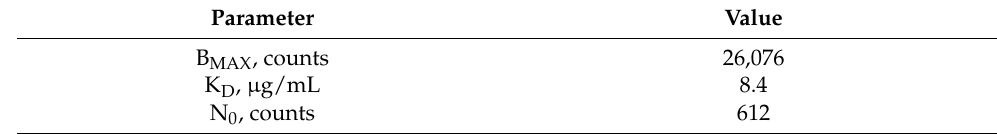
Table 1. Fitting parameters of the calibration curve in Figure 6 using equation 1.